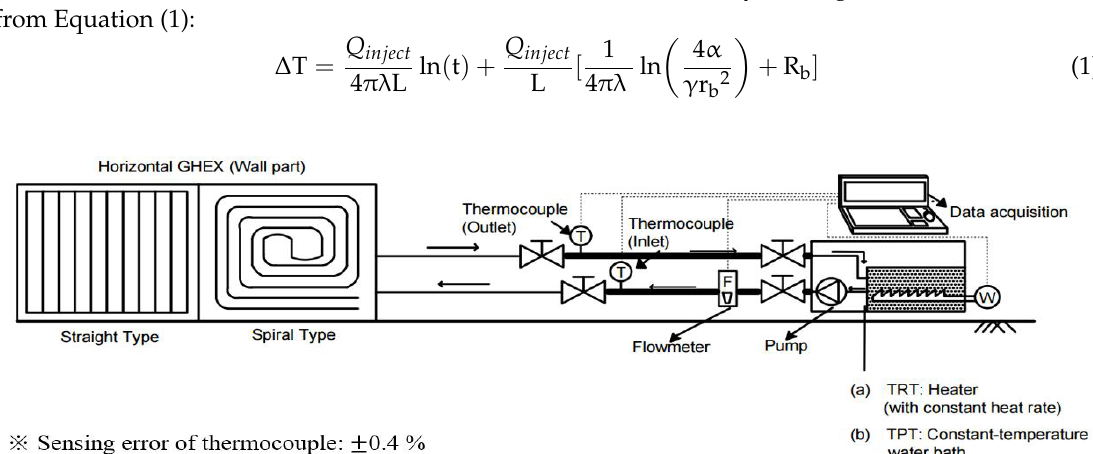
Figure 7. Schematic of in-situ field tests (thermal response tests (TRT), thermal performance tests (TPT)).